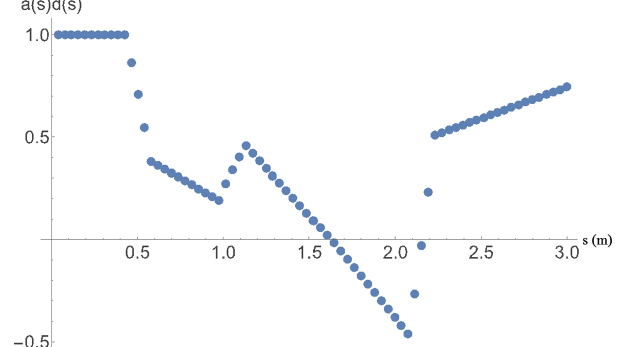
FIG. 14. Product of diagonal elements of horizontal transport matrix as function of length along the length of the CeC